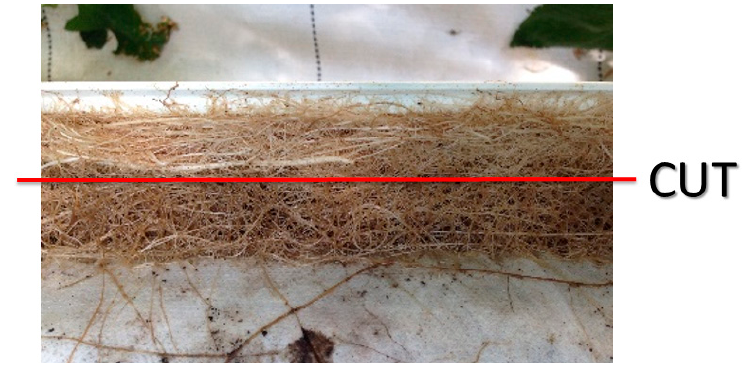
Figure A3. Cutting of the roots on both sides of the NFT channel over a period of a few days.